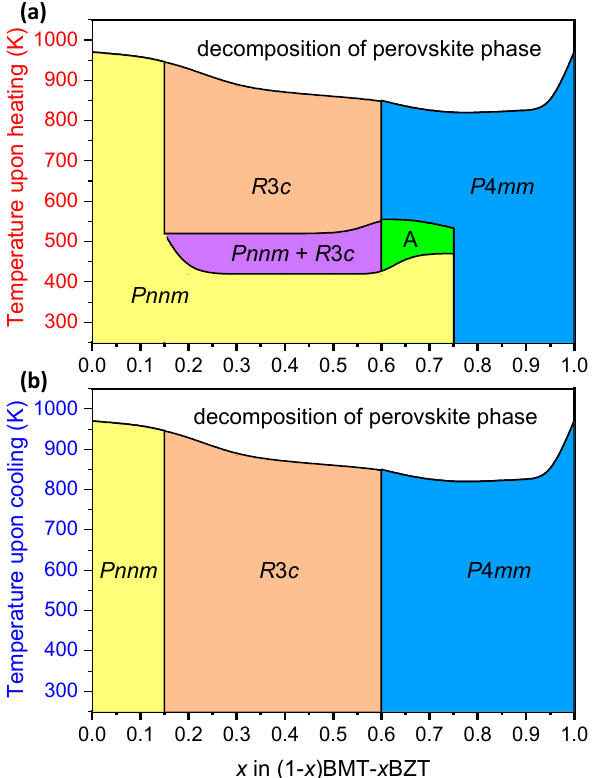
Figure 4. State diagram of the (1- x )BMT– x BZT perovskite phases upon heating to their temperature stability limit ( a ) and upon subsequent cooling ( b ). The area marked as “A” corresponds to the Pnnm + P 4 mm phase mixture.